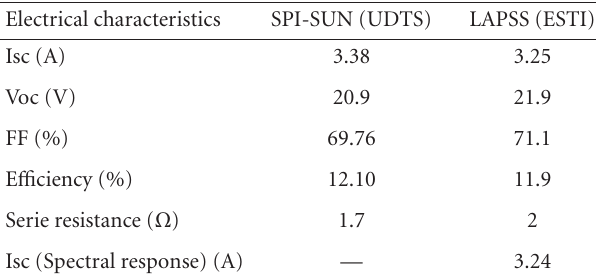
Table 4: Comparison of SPI SUN and ESTI encapsulated module electrical